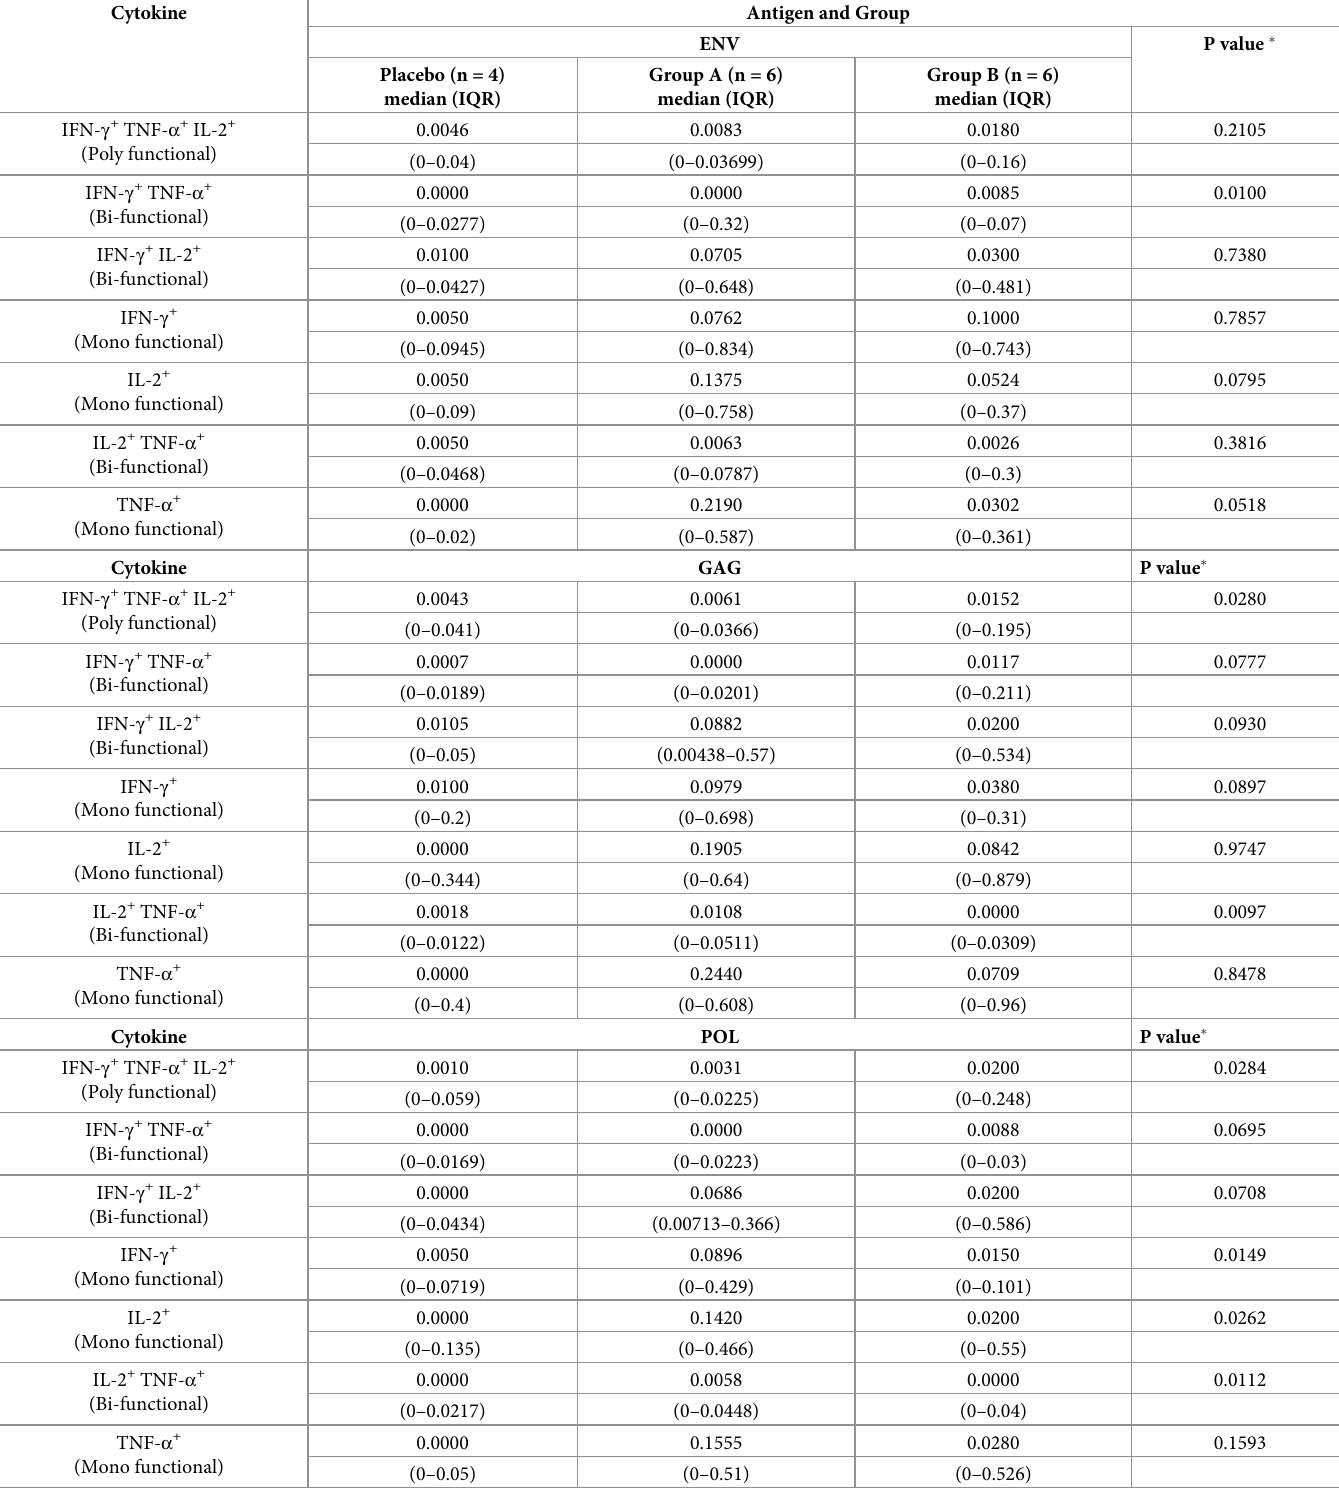
Table 3. Vaccine-induced peptide specific CD8 + T cell cytokine responses across the period of